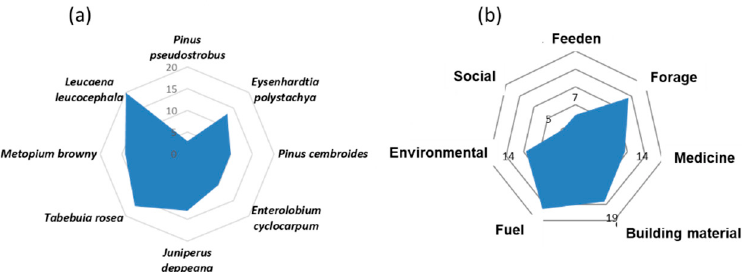
Figure 1. Eight focal species with high Vse values and which are stored at the FESI Seed Bank. ( a ) Contribution (%) in terms of uses; ( b ) distribution of diversity of uses (%) of the eight focal species selected.